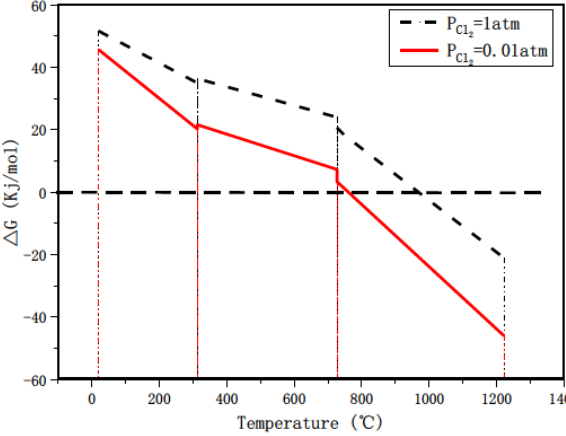
Figure 2: Gibbs free energy of the [Zn] reclaiming reaction under different standard conditions with a changing temperature